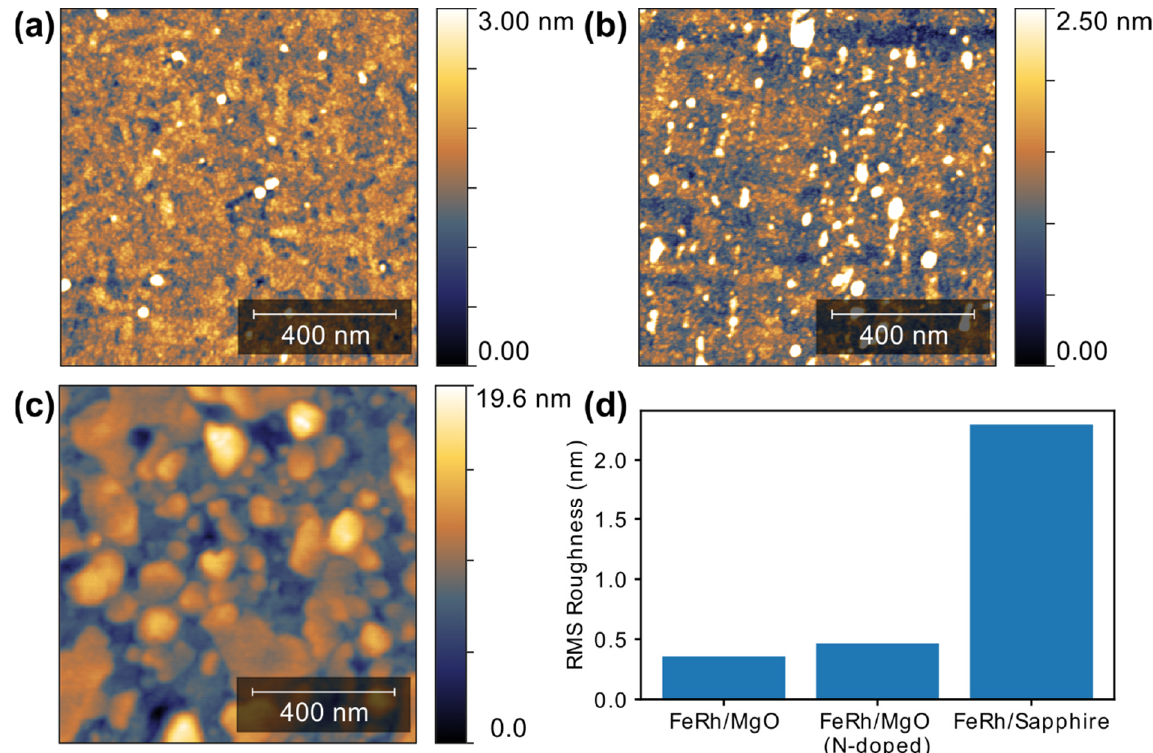
Figure 4. Atomic force microscopy (AFM) contour maps showing the topography of the FeRh films. ( a ) FeRh/MgO sample ( b ) FeRh/MgO with 5 keV N + irradiation ( c ) FeRh/Sapphire sample ( d ) Histogram showing RMS roughness for the 3 samples calculated as a average 5 scanned sites on each sample.